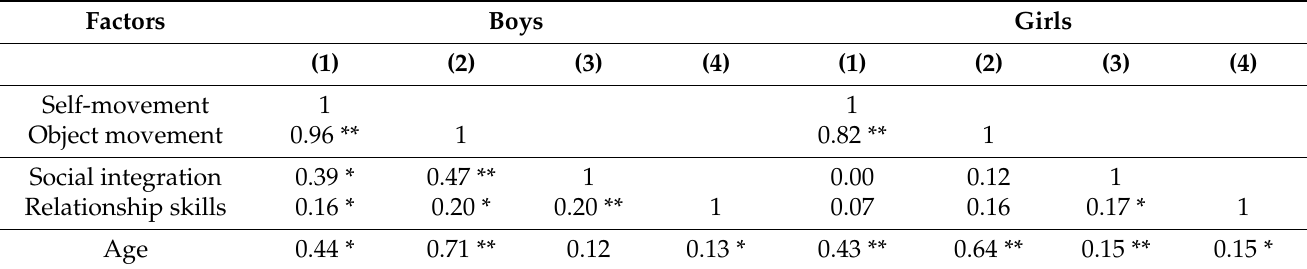
Table 3. Intercorrelations between the latent factors and with age as a covariate (model 3). Factors